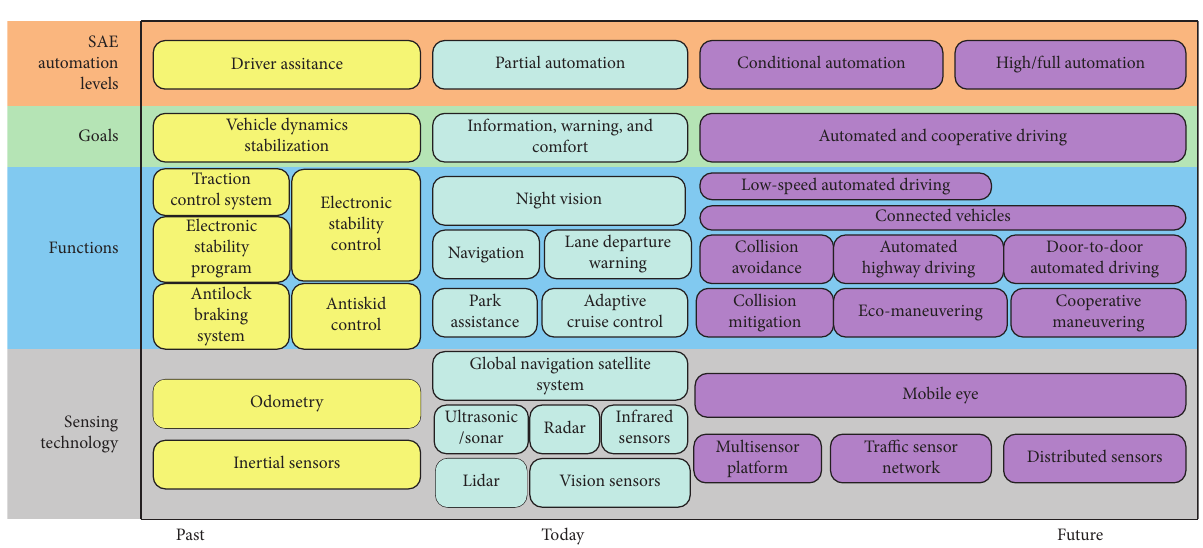
Figure 2: Past and potential future evolution of autonomous vehicle technology.